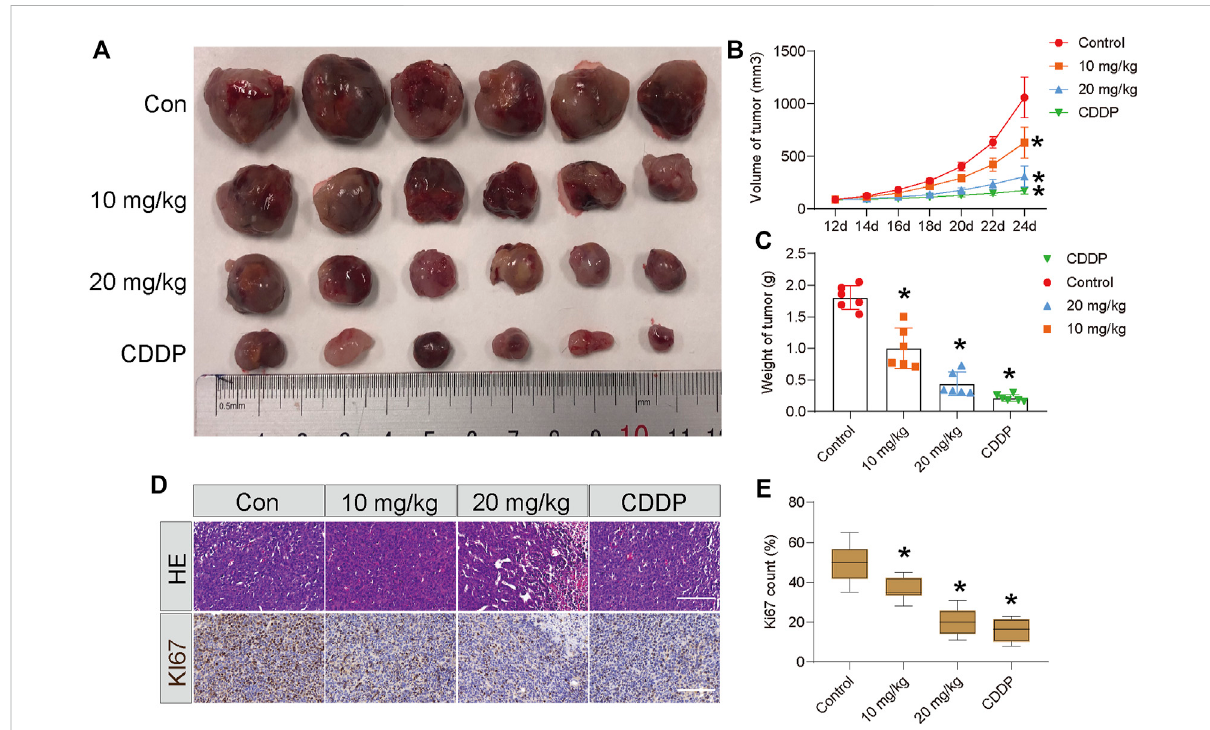
FIGURE 6 STA impairs the growth of Hep3B cells in vivo . Twenty-four nude mice were randomly divided into negative control group, positive control group (CDDP, 5 mg/kg, i.p., once two days), low-concentration treatment group (STA, 10 mg/kg, i.p., once two days) and high-concentration treatmentgroup(STA,20 mg/kg,i.p.,oncetwodays). (A) Photographoftumorsfromindicatedmice. (B) Tumorvolumeofindicatedmice. (C) Tumor weight ofindicated mice. (D) H&E staining andIHCof KI67inindicated tumors. (E) QuantitativeimageanalysisofKI67in (D) .Scale bar=50 μ m. All data were analyzed using unpaired Student t -Tests and are shown as the means ± SD. * p <